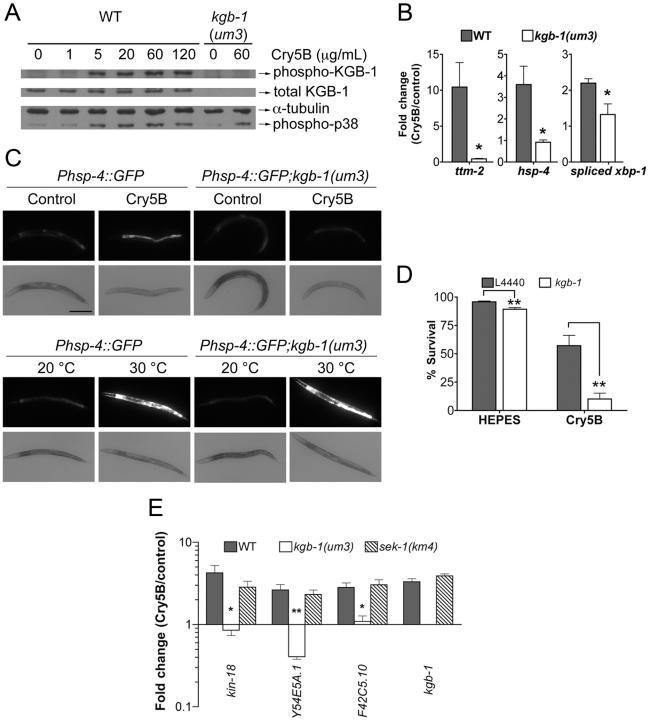
KGB-1 JNK-like MAPK regulates p38-dependent and -independent pathways involved in PFT defenses.(A) Activation of KGB-1 by Cry5B PFT. Activation was assessed by Western blotting using antibodies specific for phosphorylated and total KGB-1. α-tubulin served as an equal-loading control and phosphorylated p38 MAPK was also tested. Specificity of the antibody was verified by probing kgb-1(um3) mutant animals. The experiment shown is representative of three experiments with similar results. (B) qRT-PCR analysis of known p38 MAPK downstream target genes in response to PFT. All three target genes are regulated by KGB-1. Average of three experiments, error bars are standard error of the mean. (C) In vivo induction of Phsp-4::GFP in the intestine by Cry5B requires KGB-1. The strains Phsp-4::GFP and Phsp-4::GFP;kgb-1(um3) were fed either control E. coli or E. coli expressing Cry5B for 8 hours or shifted to 30°C for 5 hours in the heat shock treatment. Cry5B induces GFP within the intestinal cells of the strain Phsp-4::GFP but not in the strain containing the kgb-1(um3) mutant. General stress induction of Phsp-4::GFP via heat shock is independent of KGB-1. The experiment was performed three times and representative worms are shown. Scale bar is 0.2 mm. (D) Intestinal kgb-1 is required for protection against Cry5B PFT. Intestine-specific knockdown of kgb-1 in VP303 animals are quantitatively hypersensitive to purified Cry5B, compared to empty vector control (L4440). Results are the average of three different experiments; error bars indicate standard error of the mean. (E) qRT-PCR analysis of four KGB-1-dependent hpo genes in response to PFT. All these genes show a KGB-1 dependent/SEK-1 independent induction by Cry5B PFT. Average of three experiments, error bars are standard error of the mean.